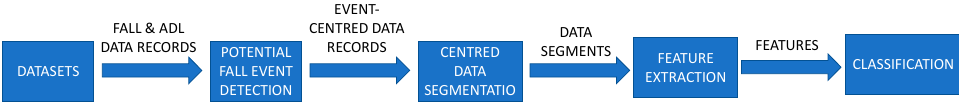
Figure 1. Architecture of the implemented testing environment for fall detection.